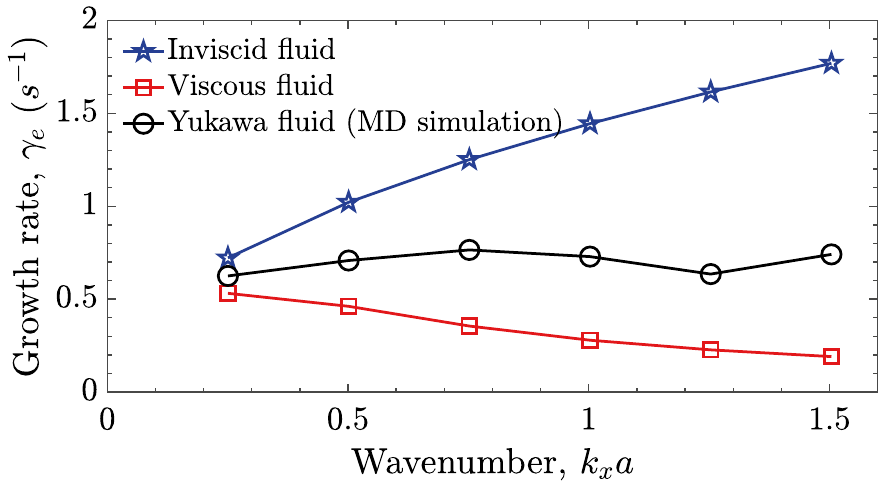
Figure 7. Comparison of dispersion relation of RTI for inviscid (blue stars), viscous (red squares) and Yukawa (black circles) fluids. Inviscid-hydrodynamic growth rate 3 is γ e = (cid:31) gA t k x and viscous-hydrodynamic growth rate (Eq. (8) in Ding et al. 23 ) is γ e = (cid:31) ν 2 k 4 x + gA t k x − ν k 2 x , with shear viscosity ν taken from Donkó et al. 26 . Yukawa fluid growth rate is obtained from MD simulations for Ŵ = 10 , κ = 0.1 , and A t = 0.7